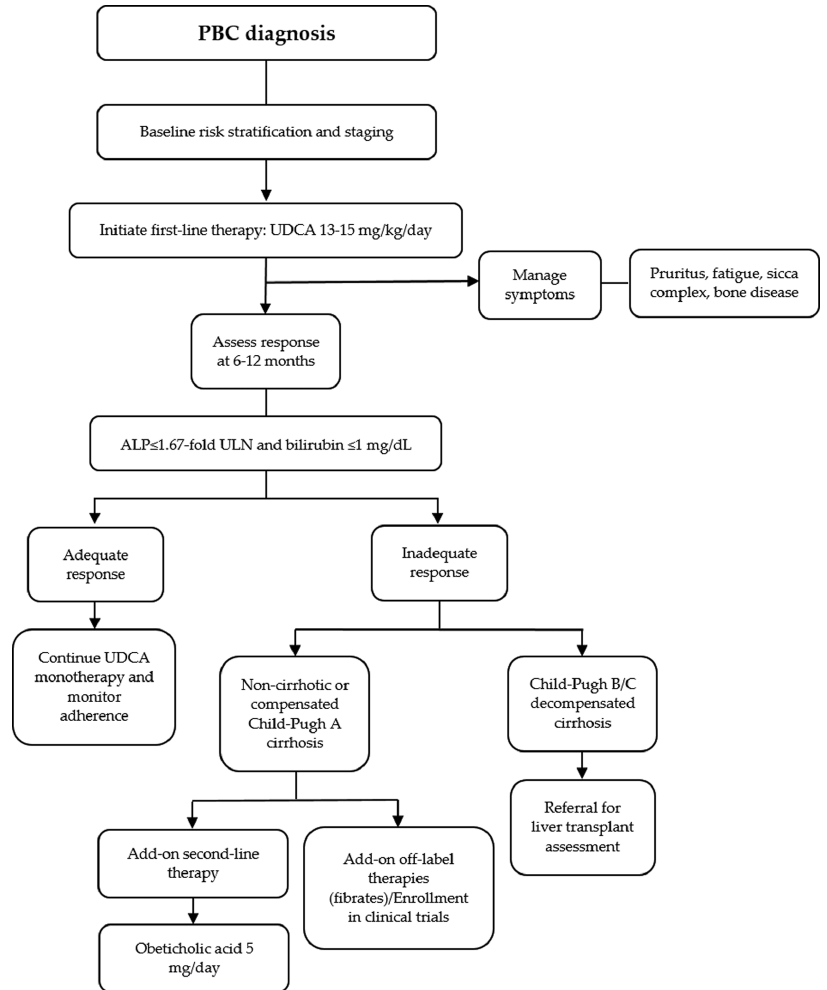
Figure 1. Algorithm for the management of PBC patients with disease-modifying agents. PBC, primary biliary cholangitis; UDCA, ursodeoxycholic acid; ALP, alkaline phosphatase; ULN, upper limit of